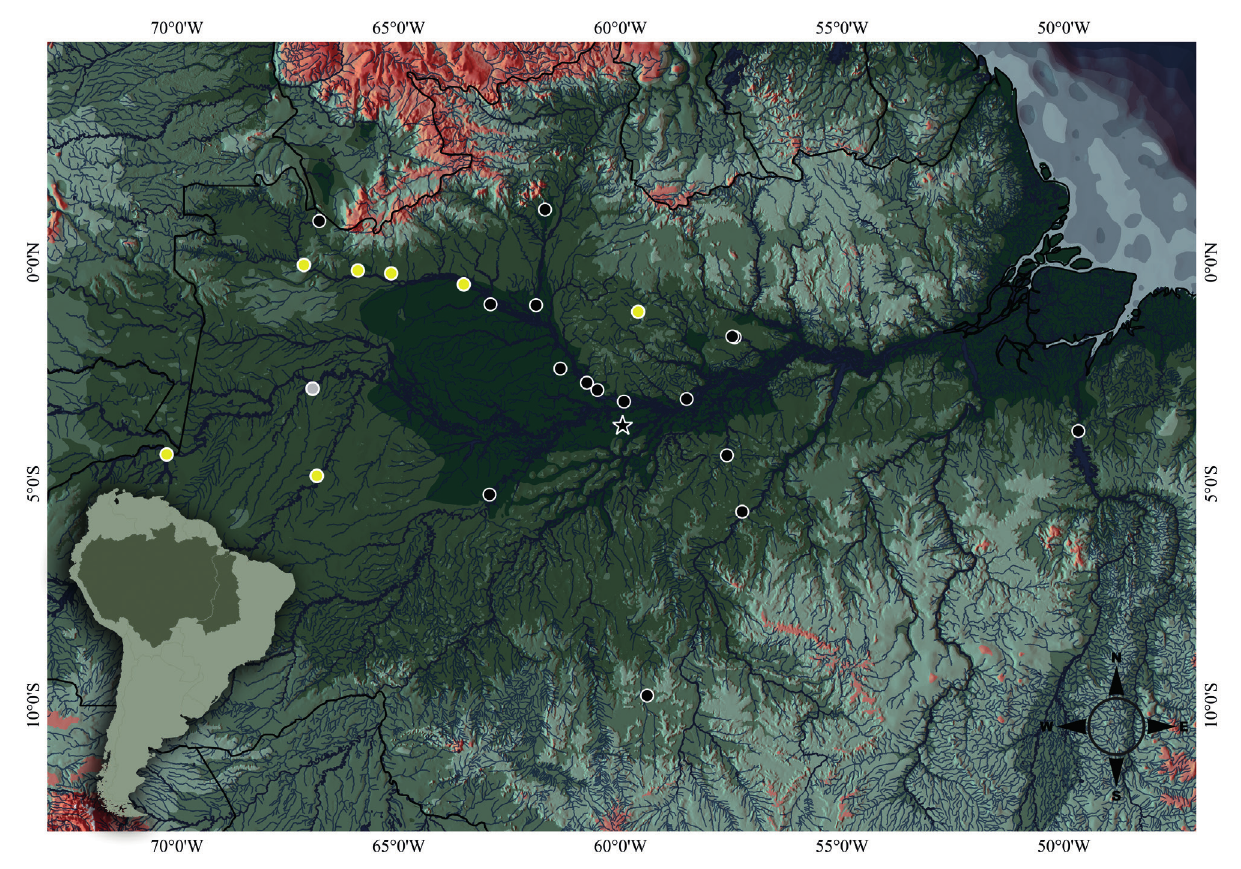
FIGURE 5 | Map of northern South America, showing the distribution of Myloplus nigrolineatus . Black star represent the type locality, black circles the paratypes, yellow the non-types localities, and the gray represents the locality of exemplars used exclusively in the molecular analyses (without voucher in